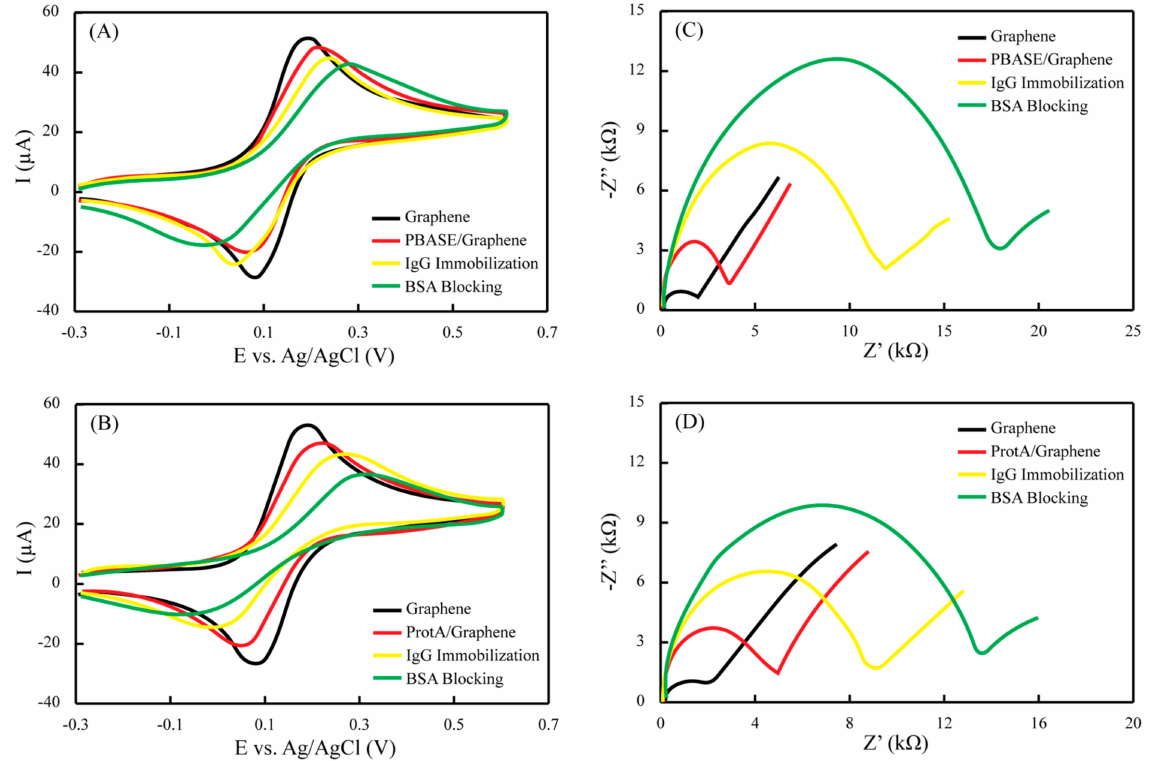
Figure 3. CV and EIS characterization of the immobilization protocols for paper-based immunochemical sensor, where ( A , B ) represent the changes in the redox processes at the interface and the shifts of the redox potentials with the addition of different biochemically interacting species, and ( C , D ) represents the changes in the impedance of the electrode surface due to the introduction of more insulating species during